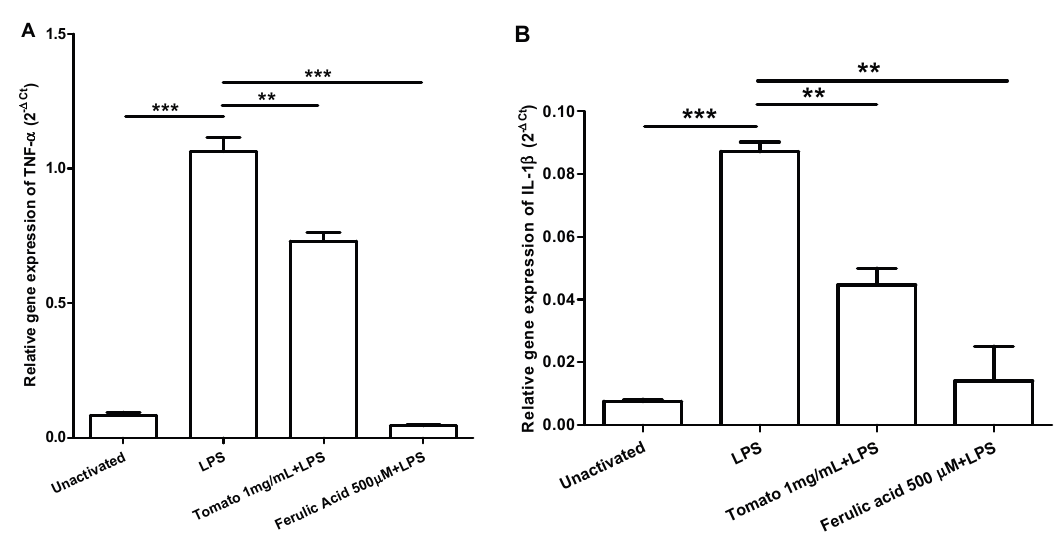
Figure 2. Aqueous tomato extract and ferulic acid inhibit expression of TNF- α ( A ) and IL-1 β ( B ) in LPS-activated macrophages. LPS, lipopolysaccharide. ** significant at the p < 0.01 level, *** significant at the p < 0.001 level.